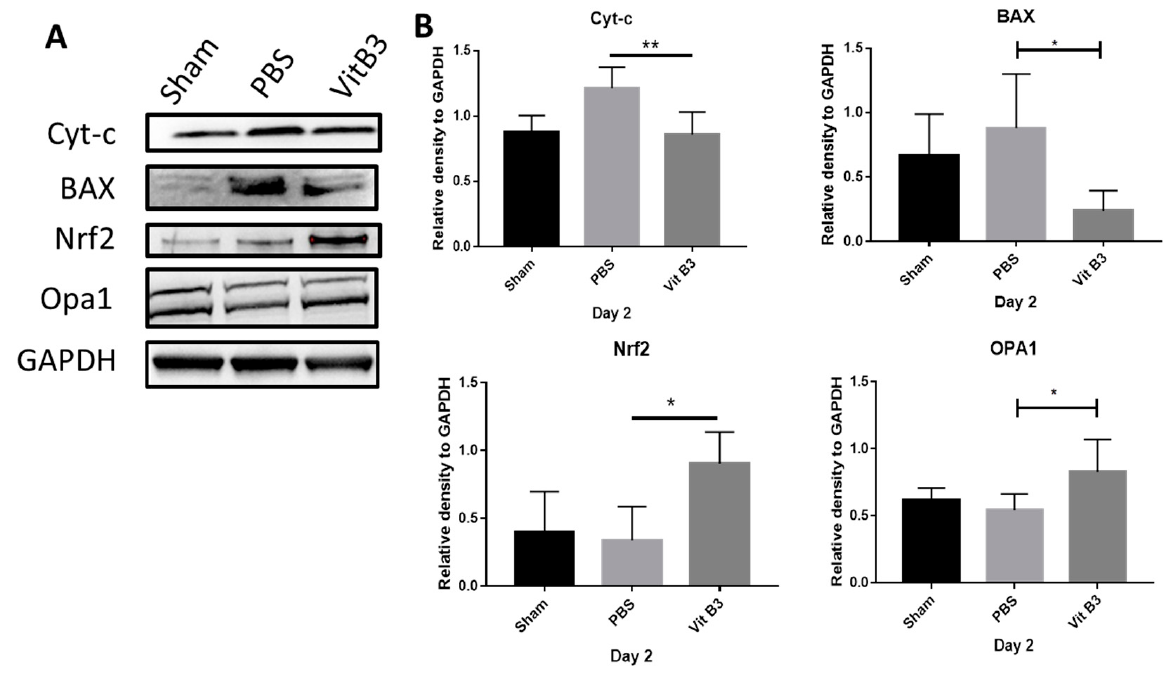
Figure 6. Analysis of the retinal expression of Nrf2, OPA1, cytochrome c, and BAX using immunoblot- ting. ( A ) Typical image of the day 2 following rAION induction Western blotting examination of the retinal samples. ( B ) Quantification of the Nrf2, OPA1, cytochrome c, and BAX protein bands. Each value was calculated with the help of the iBright imaging program and normalized to GAPDH. While the expression of Nrf2 and OPA1 was significantly higher in the vitamin B3-treated group than it was in the sham or PBS-treated group, the expression of cytochrome c and BAX was significantly lower in the vitamin B3-treated group than it was in the sham or PBS group (* p < 0.05; ** p < 0.01; n = 6 per group). Data were presented as mean ±